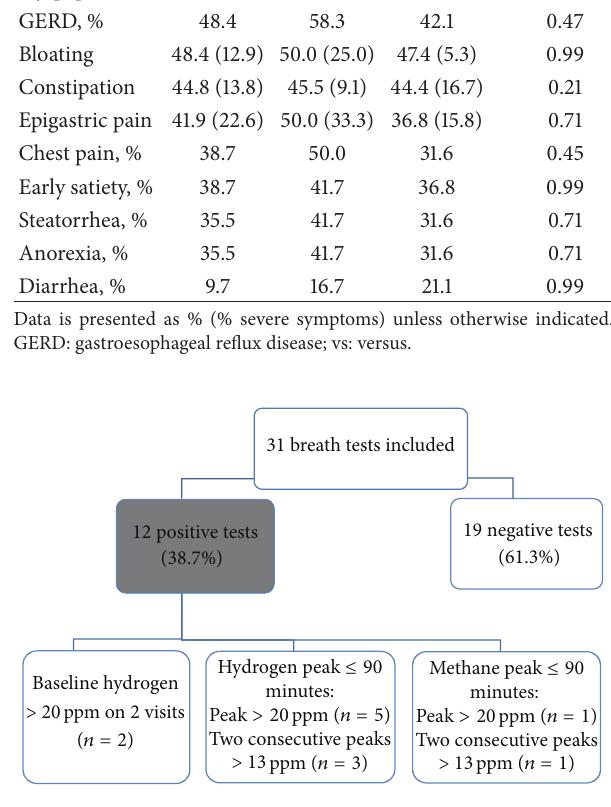
Figure 2: Breath test results of patients with chronic pancreatitis, ppm: parts per